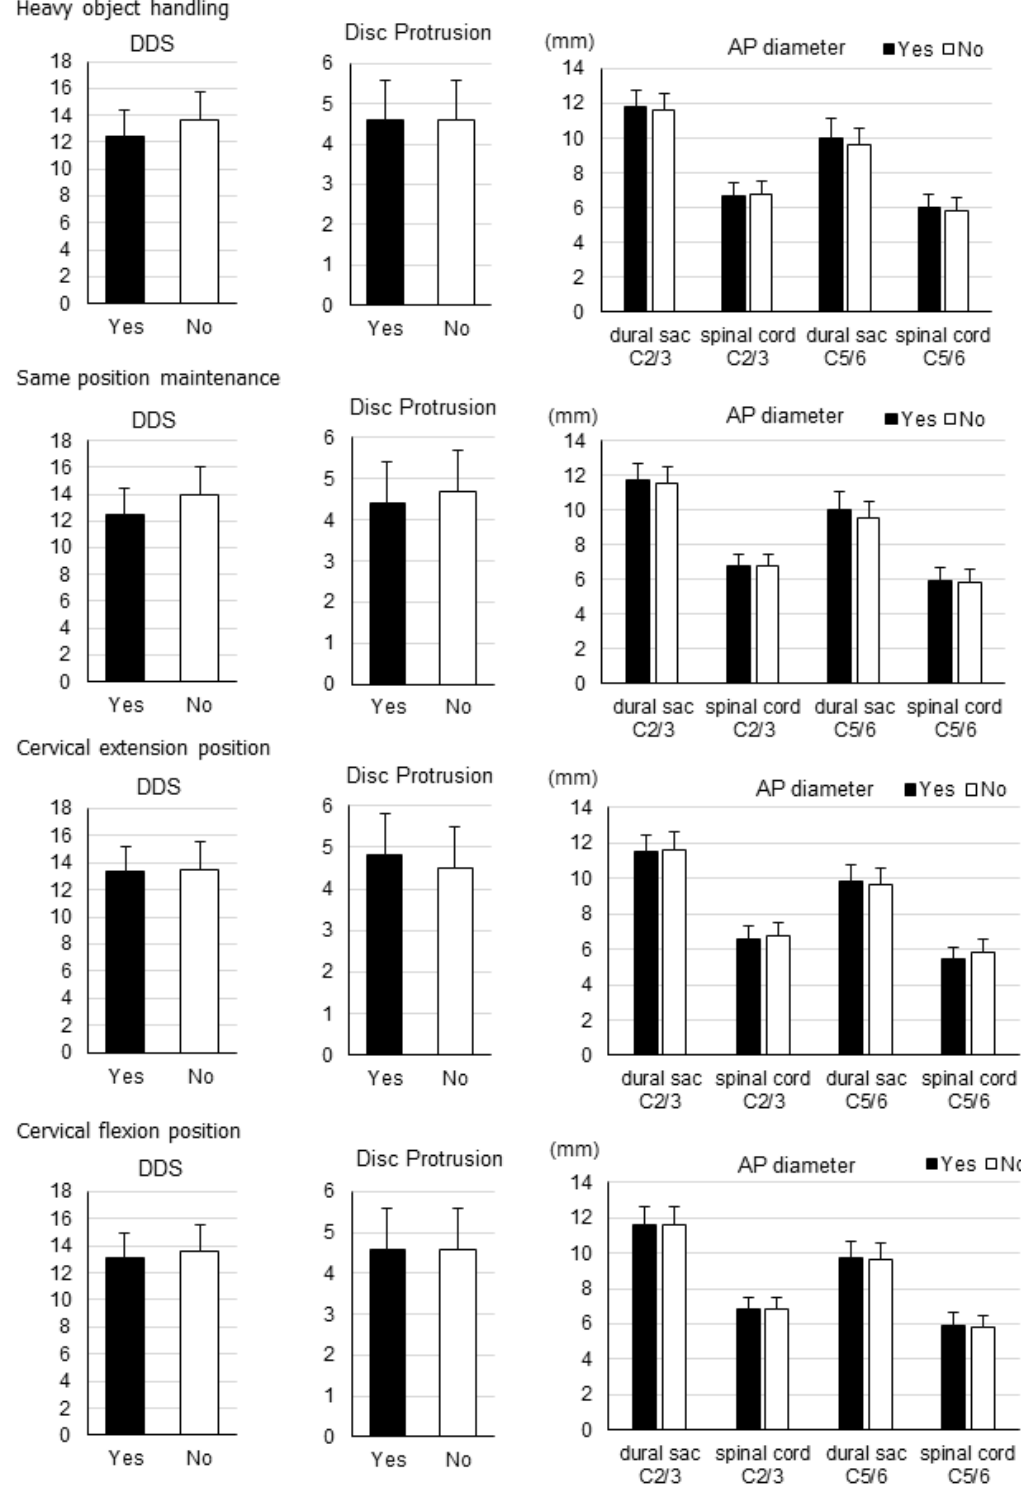
Figure 4. Disc degeneration data by labor type for females. Overall disc degeneration score (DDS), number of disc protrusions, and anteroposterior (AP) diameters of the dural sac and spinal cord at the C2/3 and C5/6 levels for each labor type in females.